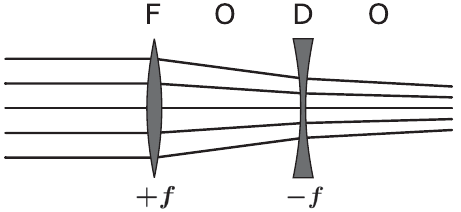
FIG. 1. The principle of FODO focusing. The best known realization of this principle is the alternating gradient focusing used in conventional rf accelerators.